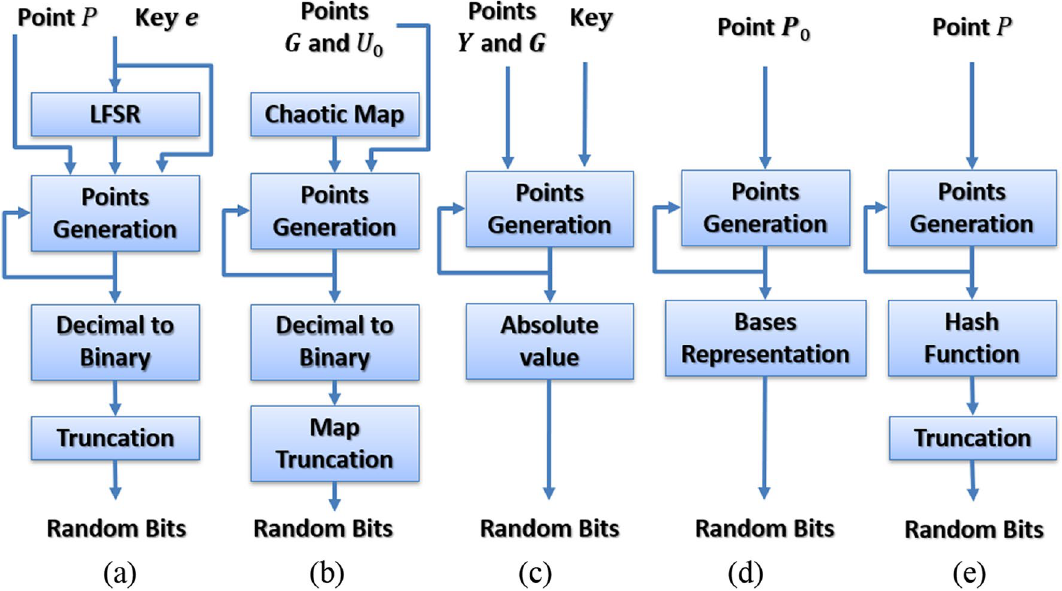
Figure 3. Simplified block diagrams for the iterative techniques in ( a ) Ref. 23 , ( b ) Ref. 24 , ( c ) Ref. 25 , ( d ) Ref. 26 ,